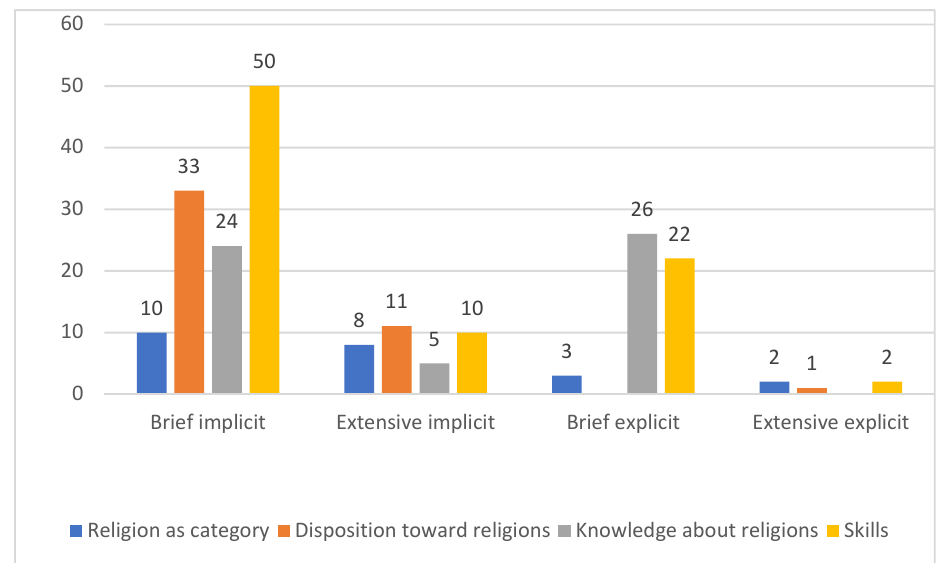
Figure 3. Elements of religious literacy according to the educational model of religious literacy (Francis and Dinham 2015; Levander and Mikkola 2009). Basic schools and upper secondary schools, shown together.